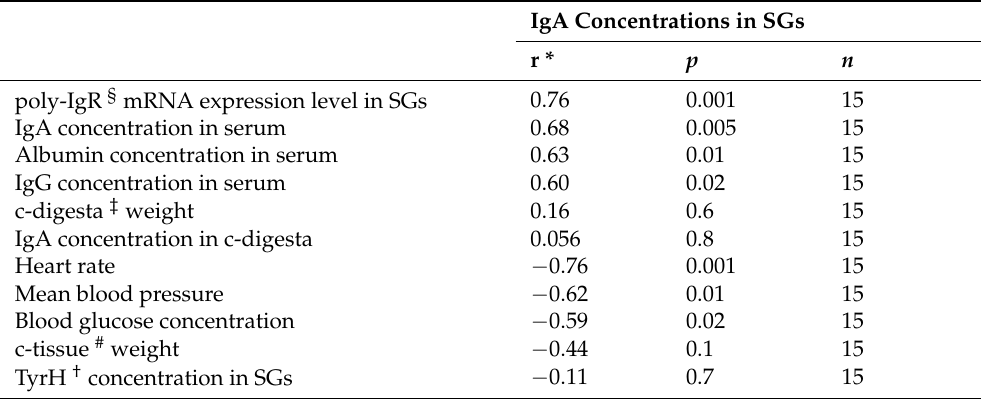
Table 1. Correlation between immunoglobulin (Ig) A concentrations in the submandibular glands (SGs) and different parameters.